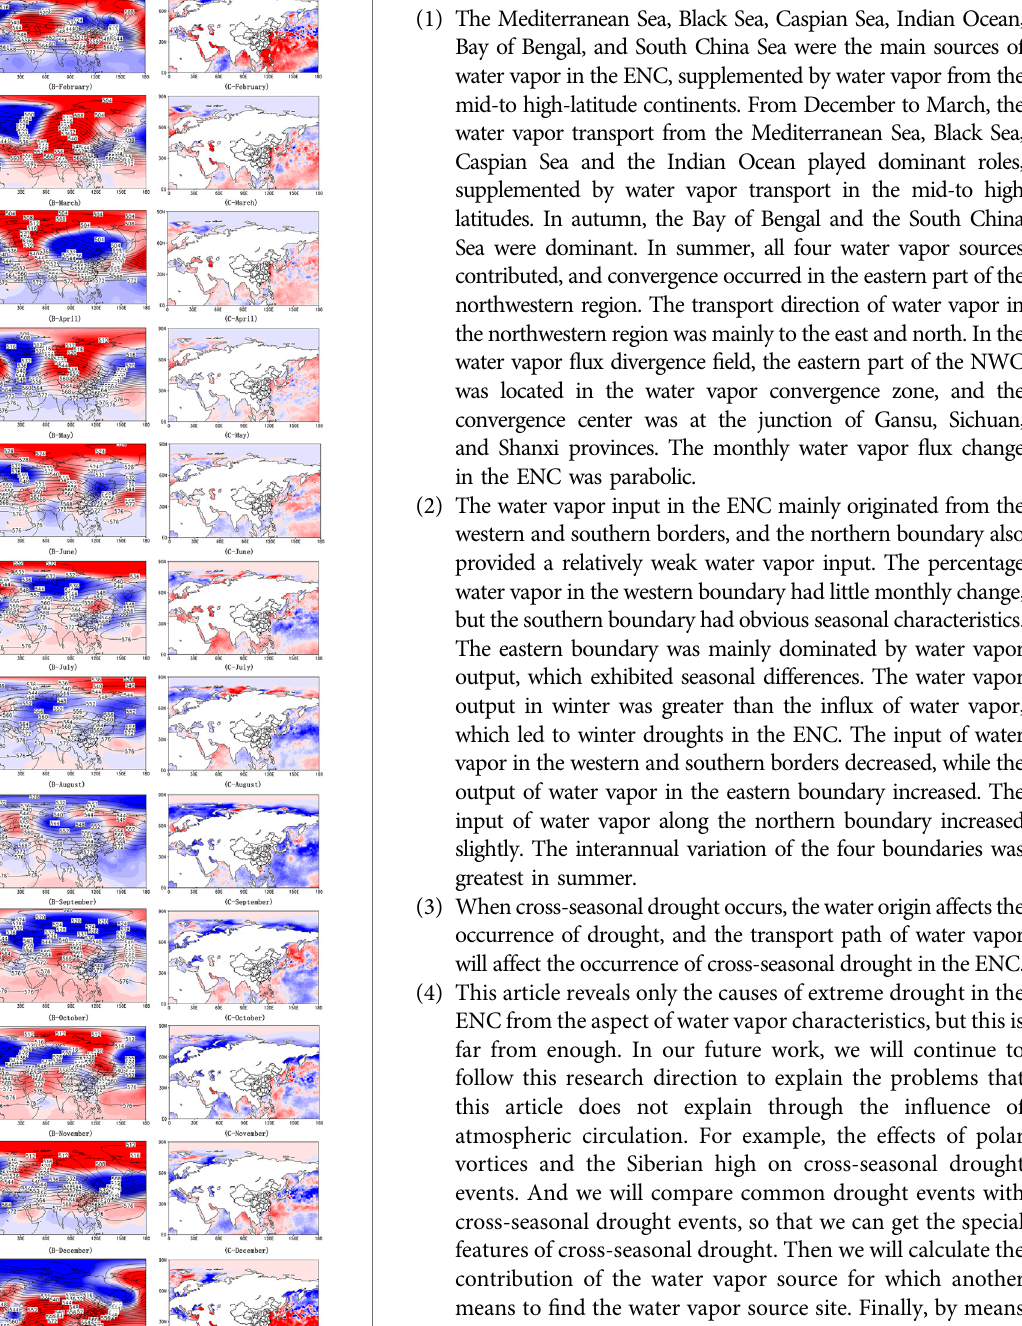
Frontiers in Earth Science |